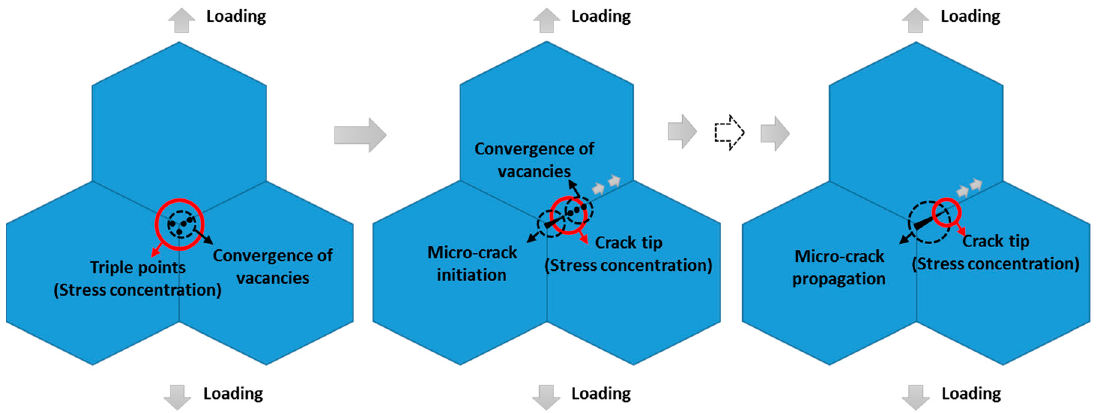
Figure 3. Crack growth by diffusion mechanism.